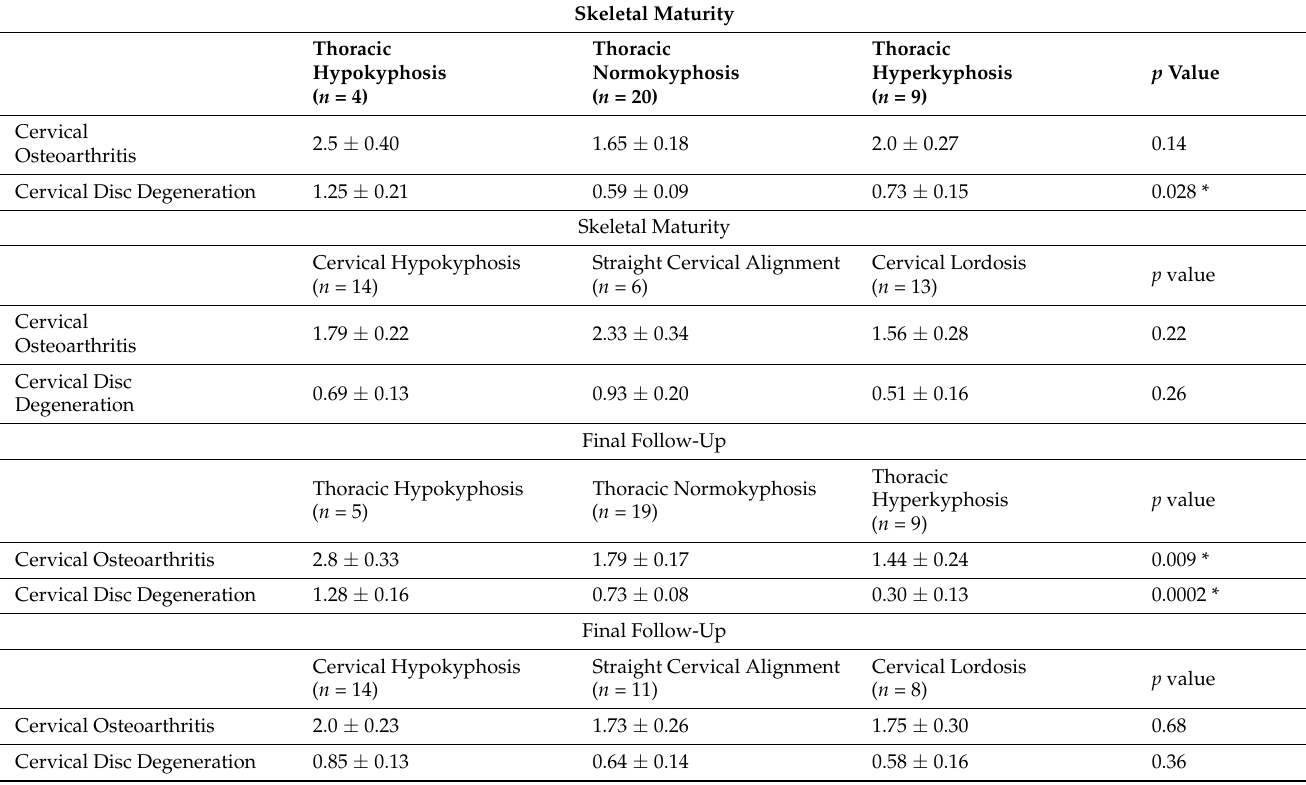
Table 2. Comparison of cervical and thoracic sagittal alignment and cervical degeneration at skeletal maturity and at final follow ‐ up.